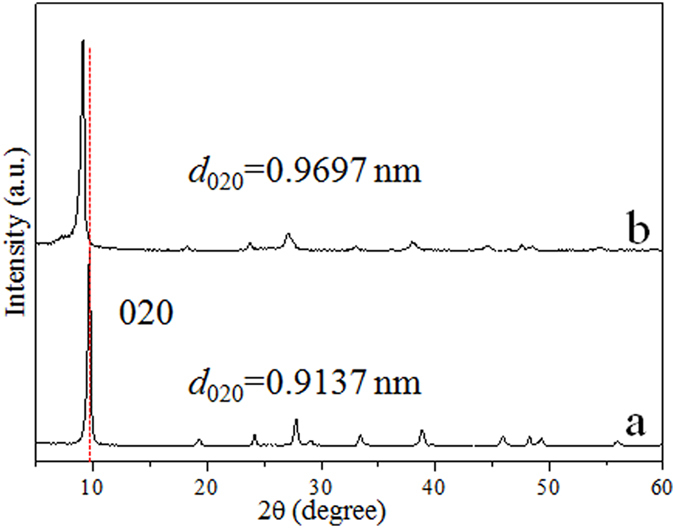
XRD patterns of the HTO crystals (a) before and (b) after treatments H2O2 solution, respectively.